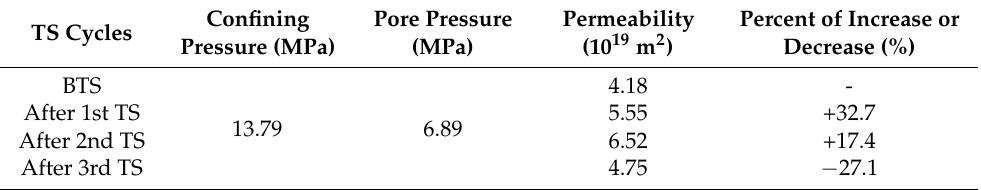
Table 5. Permeability results of core sample EF#5 before and after thermal shocking.